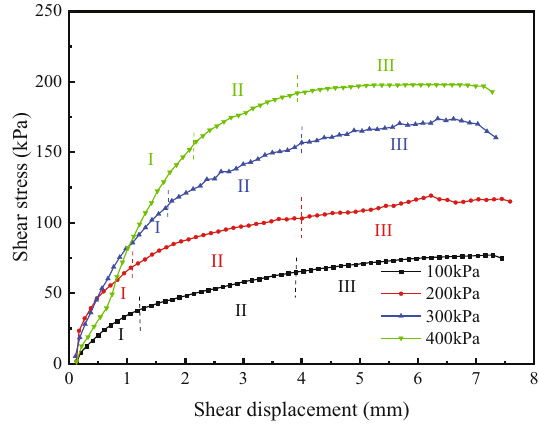
Figure 15: Shear stress – shear displacement curve of